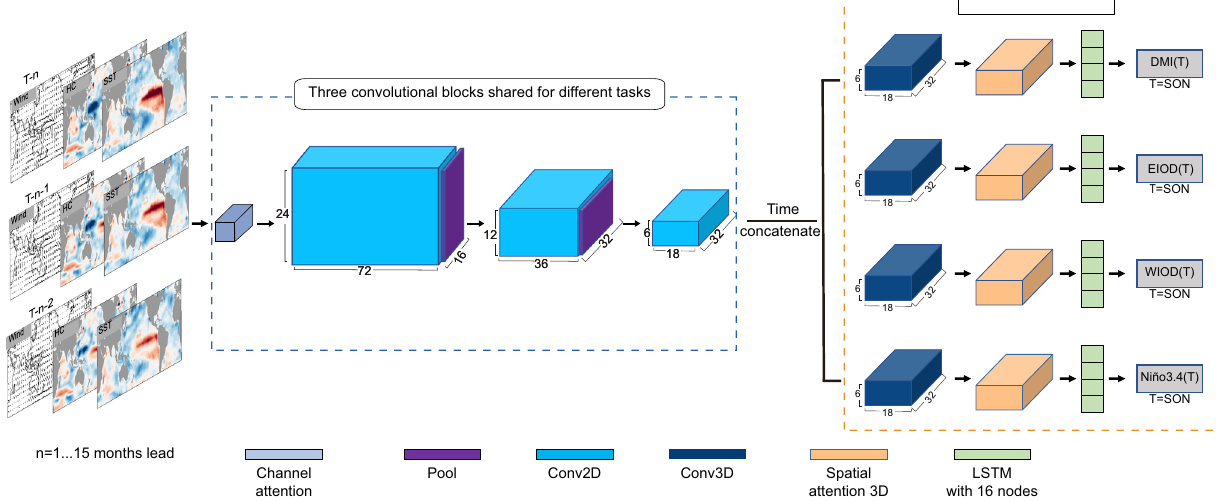
Fig.1|Thestructureofthemulti-tasklearningmodel(MTL-NET). TheMTL-NET contains three input layers (i.e., the predictors in each month) and each input will use the convolutional block to extract spatial features. The convolutional block consists of one channel attention layer, three convolutional layers and two max- imum pooling layers. Then, the spatial features in each month are concatenated according to the time dimension and fed into the different tasks. Each task block contains a 3d convolutional layer, a spatial attention layer, a long short-term memory (LSTM) layer, and an output layer (i.e., dense layer, the predictand). The